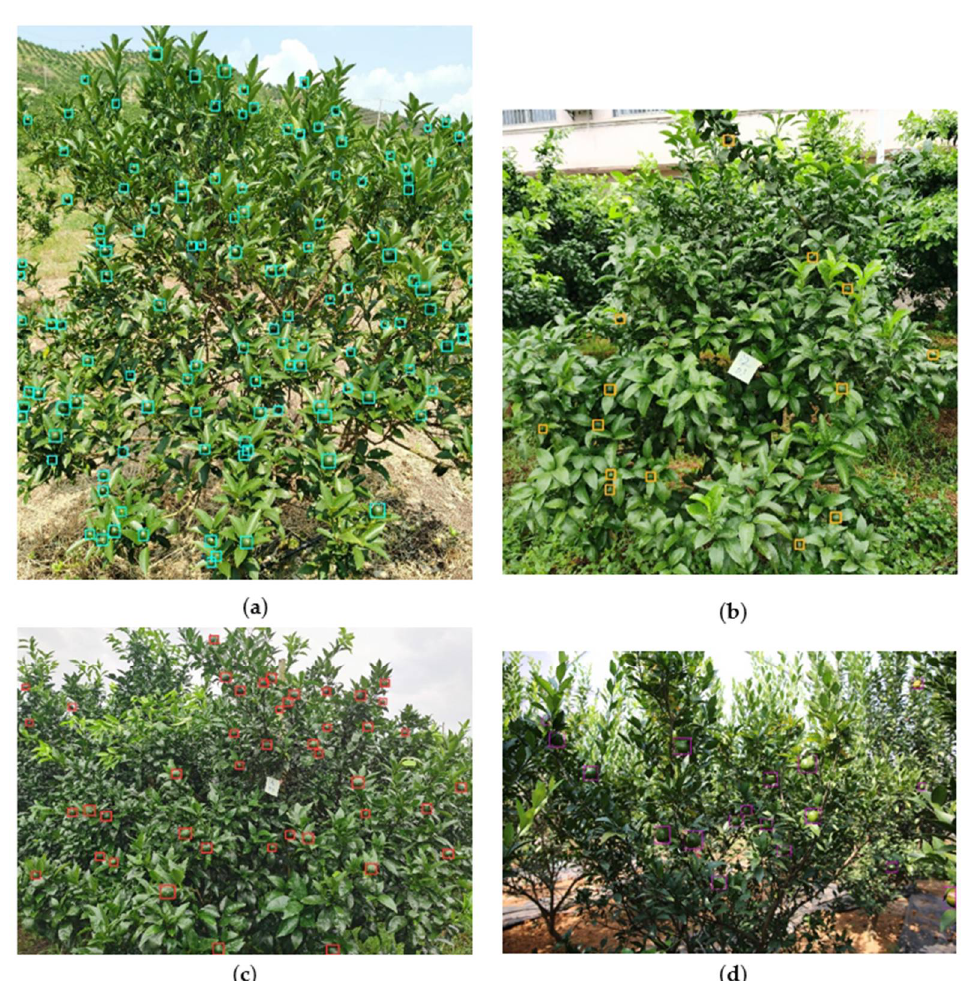
Figure 12. The detection effects of the improved YOLOv5 on different varieties: ( a ) Kumquat; ( b ) Shatang tangerine; ( c ) Fertile orange; ( d ) Nanfeng tangerine.